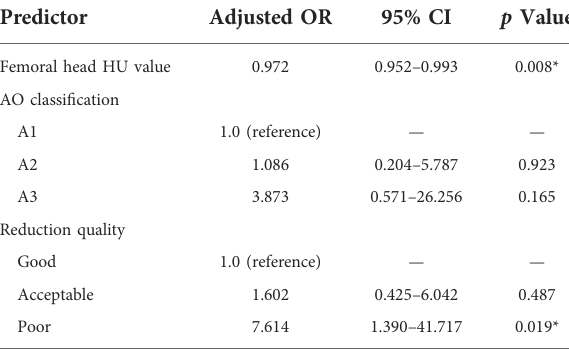
TABLE 3 Multivariable logistic regression analysis for risk factors associated with implant